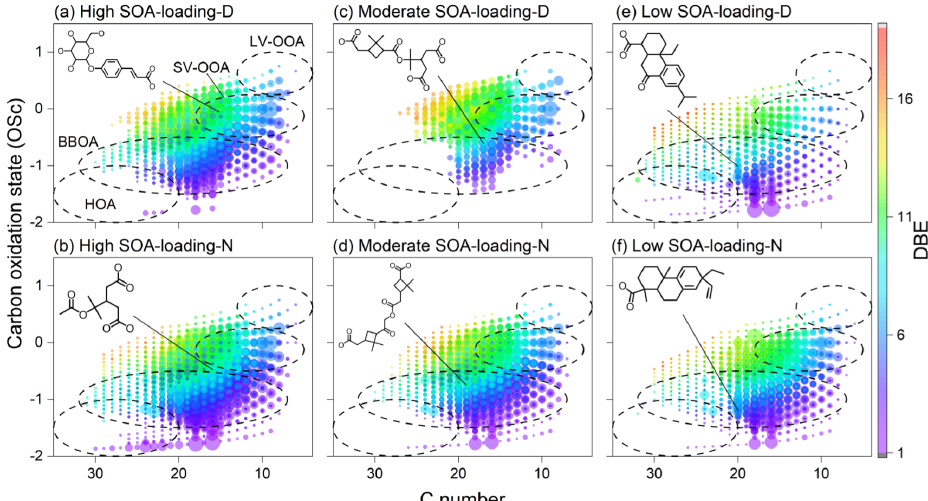
Figure 5. The carbon oxidation state (OS C ) versus C number of CHO compounds. The size and color bar denote the relative peak intensity and DBE value. The dashed circles are marked as SV-OOA (semi-volatile oxidized organic aerosol), LV-OOA (low-volatile oxidized organic aerosol), BBOOA (biomass-burning organic aerosol), and HOA (hydrocarbon-like organic aerosol). The formulae for biogenic SOA com- pounds with relatively high intensity were C 15 H 18 O 8 , C 16 H 24 O 8 , C 19 H 28 O 7 , C 17 H 26 O 8 , C 20 H 26 O 3 , C 20 H 30 O 2 , respectively. Note that the proposed structures were representative, not determined.